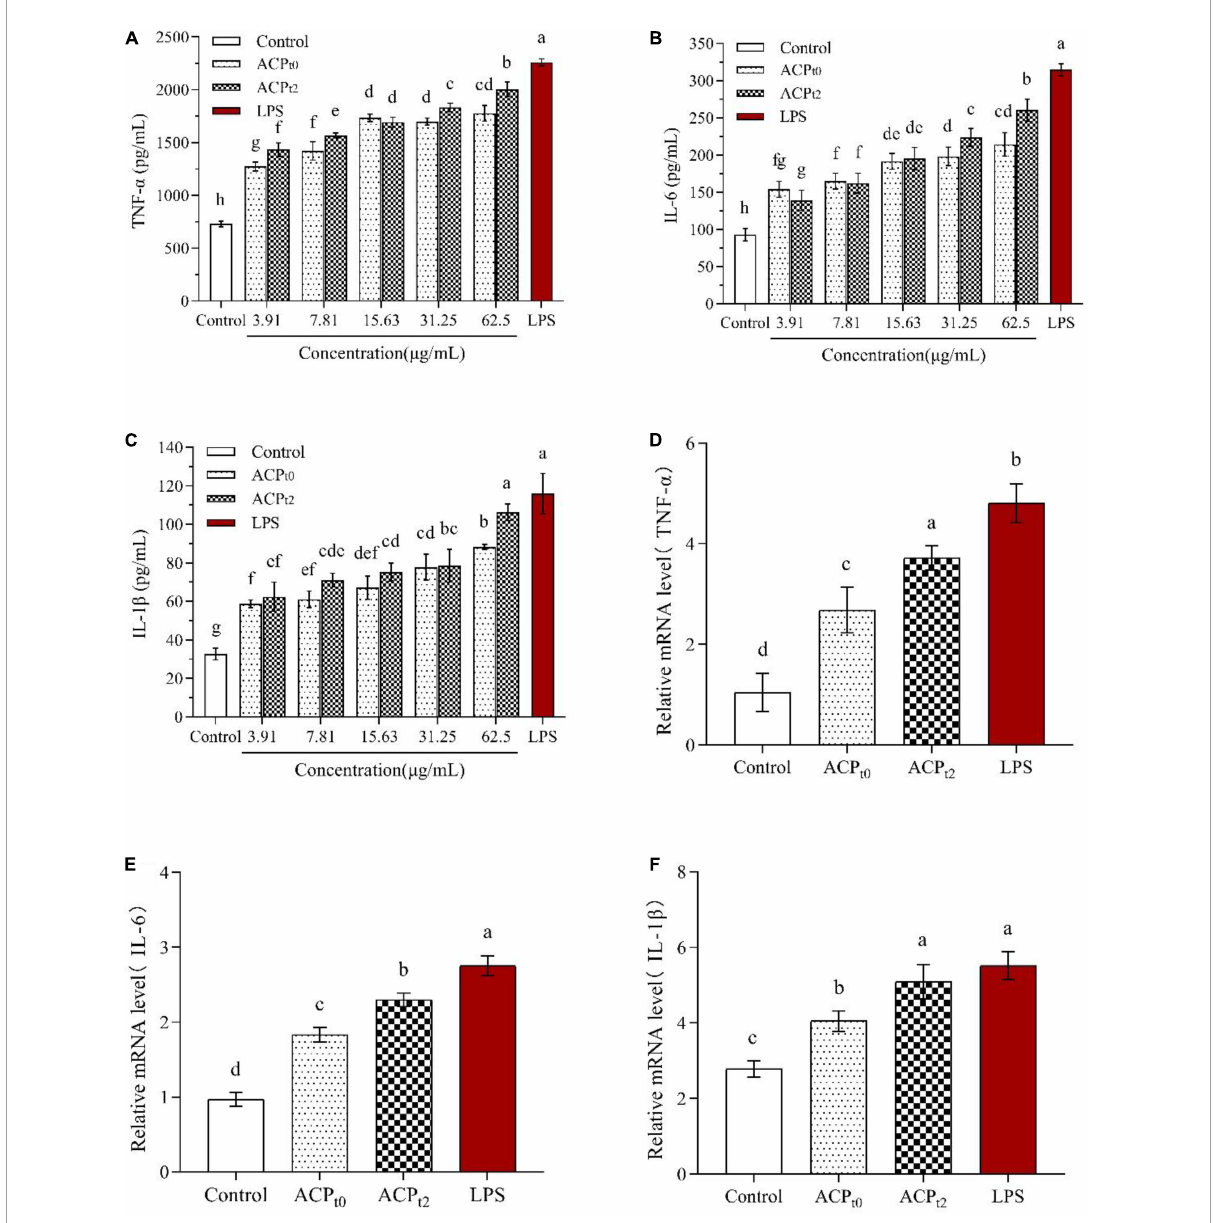
FIGURE7 Effects of ACP t 0 and ACP t 2 on secretion of TNF- α (A) , IL-6 (B) , and IL-1 β (C) , relative mRNA expression levels of TNF- α (D) , IL-6 (E) , and IL-1 β (F) in macrophages. The different letters in the column indicate statistically significant differences ( P < 0.05).